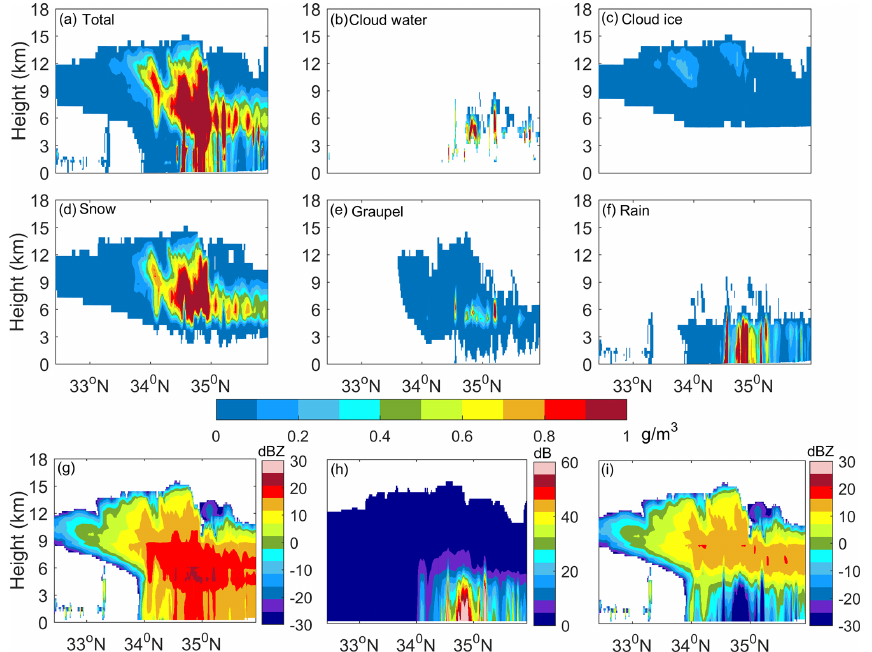
Figure 12. Latitude–height cross section of the hydrometeor of the convective case simulated by the WRF for (a) total hydrometeors, (b) cloud water, (c) cloud ice, (d) snow, (e) graupel, and (f) rain. (g) Simulated unattenuated radar reflectivity with the total hydrometeors, (h) two-way attenuation, and (i) attenuated radar